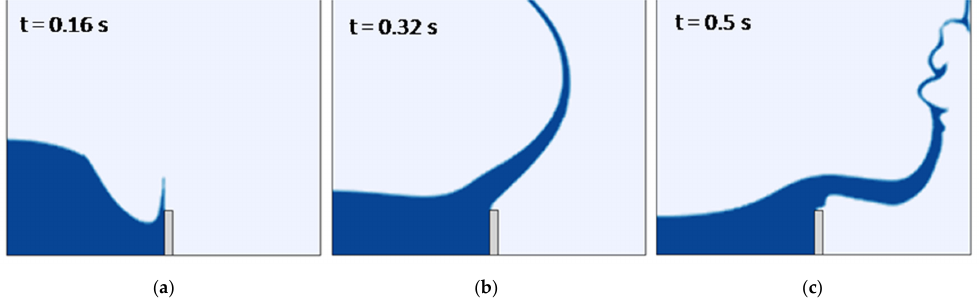
Figure 1. Simulated collapse of a water column, on the left, and its slamming on a plate, in the middle, and its splashing at a wall, on the right [9]. The simulation is produced by a solver for the Navier–Stokes equations.